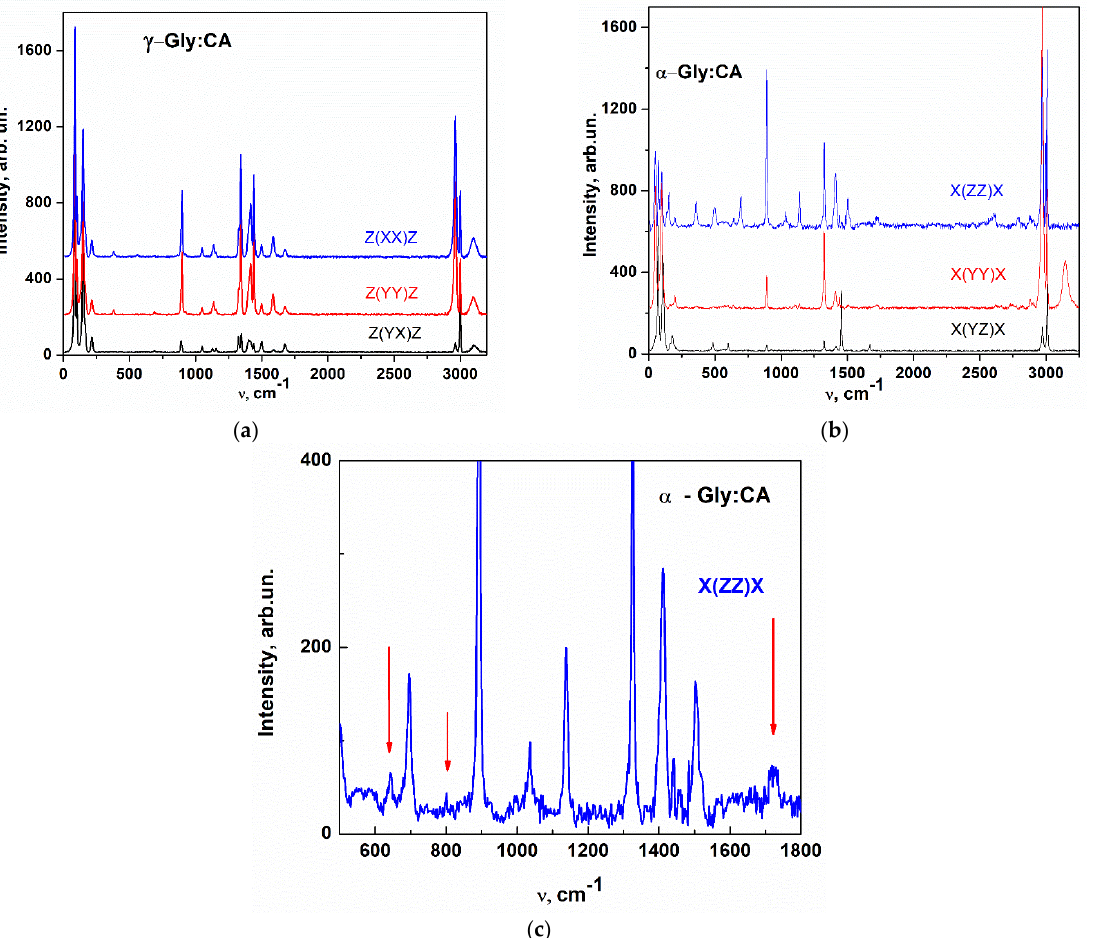
Figure 4. Polarized Raman spectra of pyramidal ( a ) and plate-like ( b ) Gly:CA crystals after subtracting the photoluminescence background. Fragment of the plate-like Gly:CA spectrum on an enlarged scale ( c ). For pyramidal crystals, the Z-axis is parallel to the polar axis (the height of the pyramid); for plate-like crystals, the Y-axis is parallel to the C 2 axis. The red arrows in ( c ) indicate positions of lines observed in CA crystals. λ exc = 532 nm. Table 8. Positions of lines ( ν , cm −1 ) observed in polarized Raman and FTIR spectra of γ -Gly:CA (80:20) crystals and assignments of analogous lines in nominally pure γ -Gly from Ref. [58].